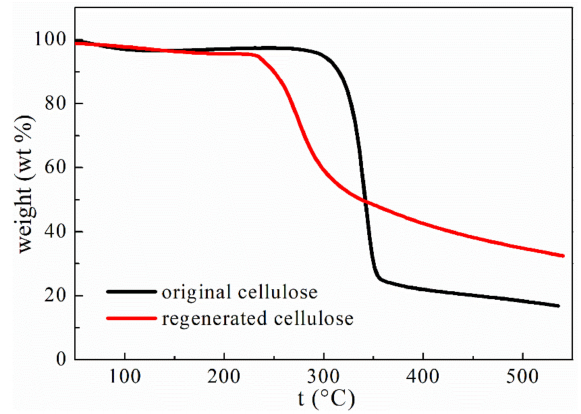
Figure 7. Thermal decomposition profiles of the original cellulose, and the cellulose regenerated from the developed [AAeim][OAc]/DMSO co-solvent